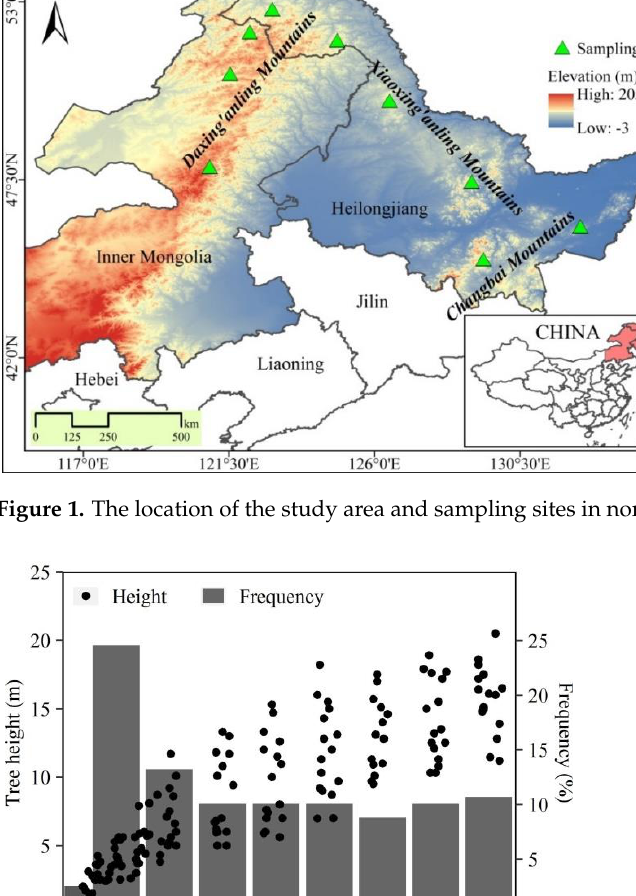
Figure 1. The location of the study area and sampling sites in northeastern China.